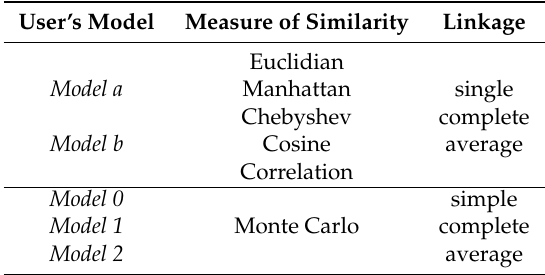
Table 1. Summary of models used for